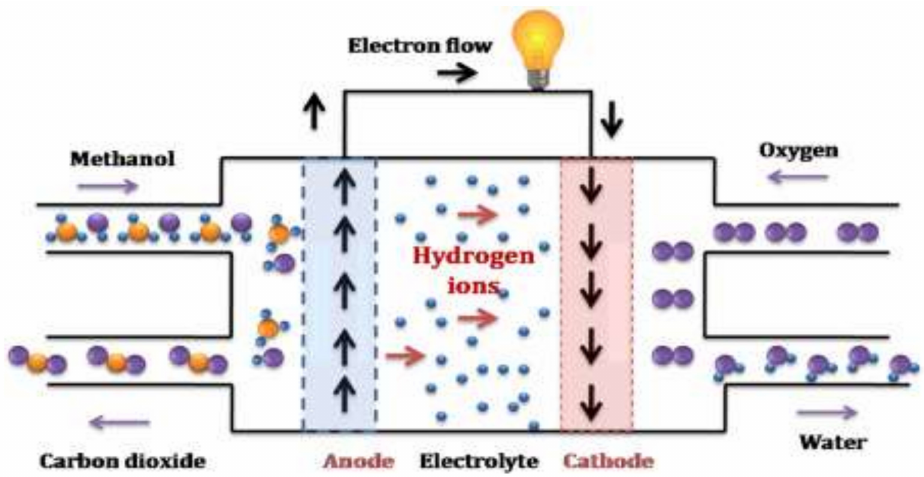
Figure 2. Schematic diagram of the direct methanol fuel cell